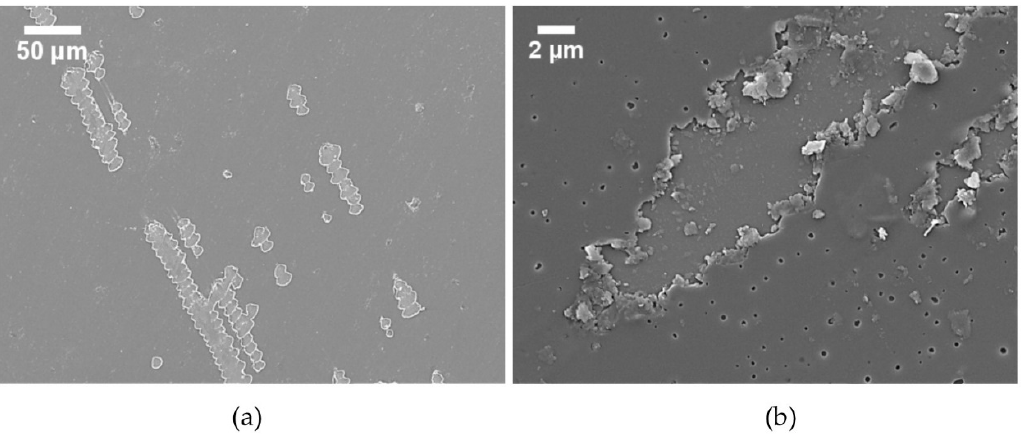
Figure 7. Abrasion damage caused by cleaning of ( a ) cleaned B coupon at 4 weeks and ( b ) cleaned A coupon at 15.3